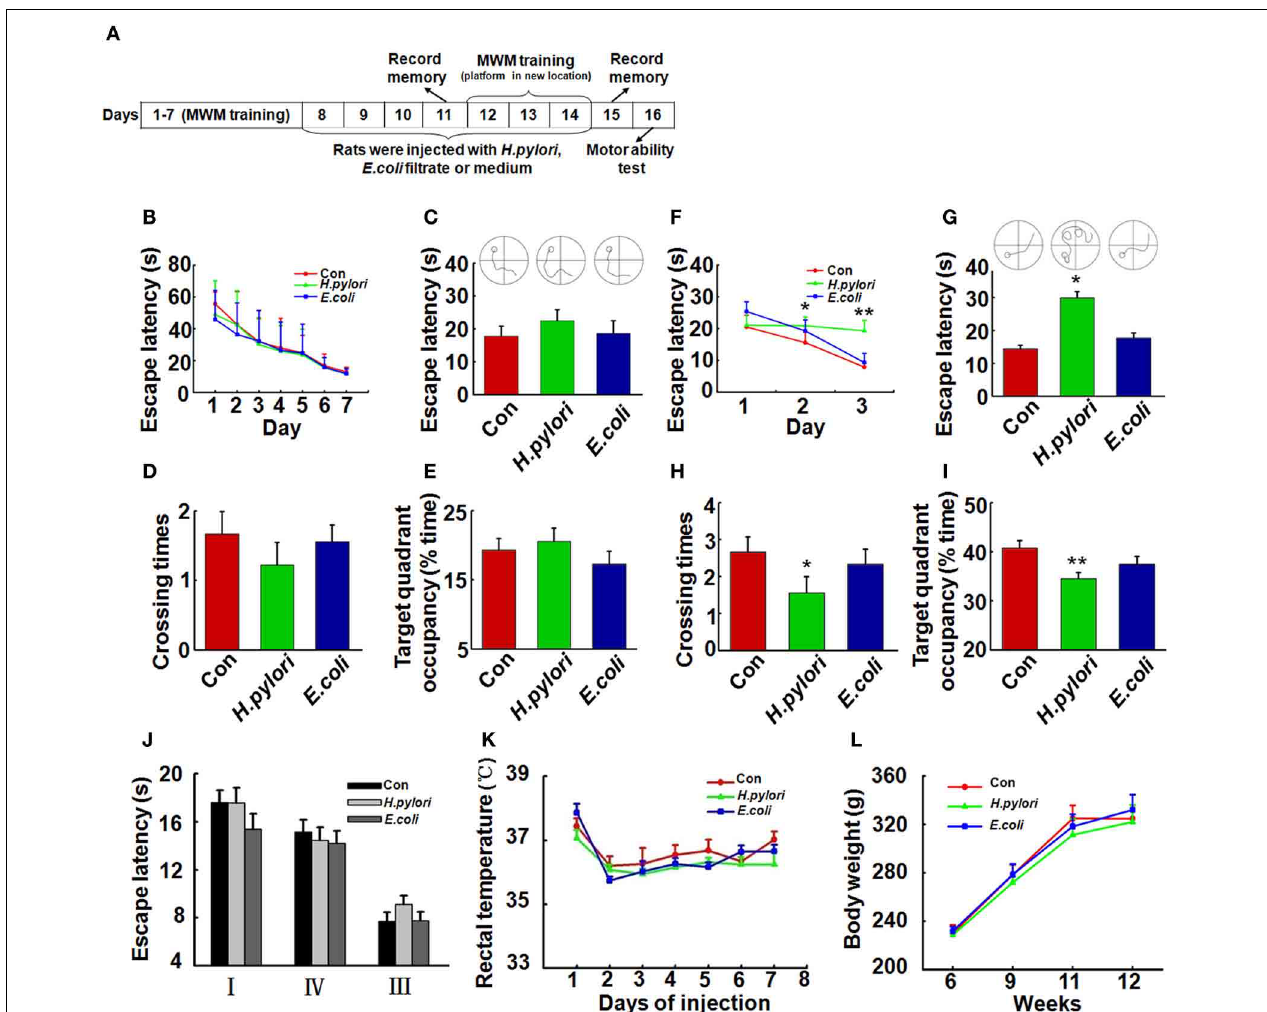
FIGURE 1 | Intraperitoneal injection of H. pylori filtrate induces spatial learning and memory impairment in rats. (A) A schematic diagram for the treatment and behavior test of the rats. Thirty-four SD rats (male, 220 ± 20g) were trained in Morris water maze (MWM) for 7 days, 27 rats which could find the hidden platform within 15s at the end of training were selected and divided into three groups ( n = 9 for each group) randomly. The rats were then intraperitoneally injected with H. pylori , E.coli filtrate or DMEM/Opti-MEM medium (280 μ l/rat/day) for 7 days. On day 11 of behavior test (day 4 of injection), the spatial memory of the rats in MWM was measured. The rats were then trained in MWM for another 3 days with altered location of the hidden platform (re-learning) for testing the spatial learning ability. On day 15 (1 day after the end of injection) the new spatial memory was measured. On day 16 the motor ability of the rats was detected by recording the escape latency to a visible platform in the MWM. At the end of behavior test, the rats were anesthetized and decapitated, and the hippocampal extracts or brain slices were prepared for further studies. (B) All the rats were trained to find the hidden platform within 15s before the injection. (C–E) Intraperitoneal injection of H. pylori filtrate for 3 days does not impair the formed spatial